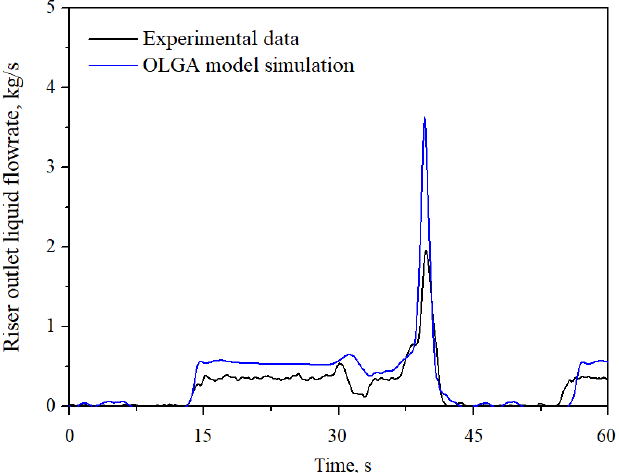
Figure 16. Experimental and simulated liquid production trends during severe slugging ( U GS = 0.08 m/s and U LS = 0.09 m/s).